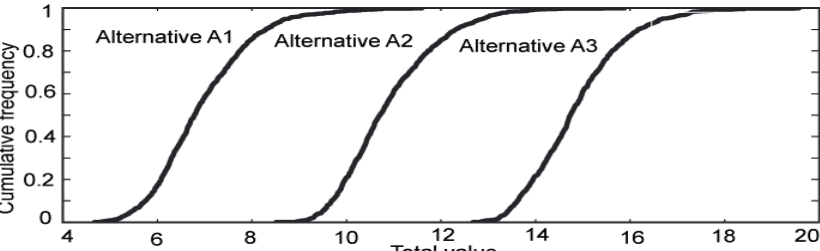
Fig. 4 Cumulative distribution functions (CDFs) generated using OWA operator for the optimism degree of 0.5, for alternatives A1, A2, and